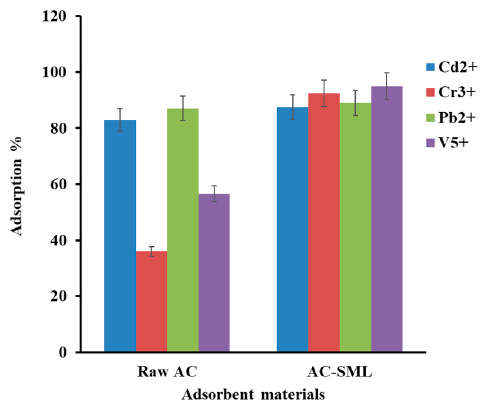
Figure 4. Influence types of materials on adoption efficiency.